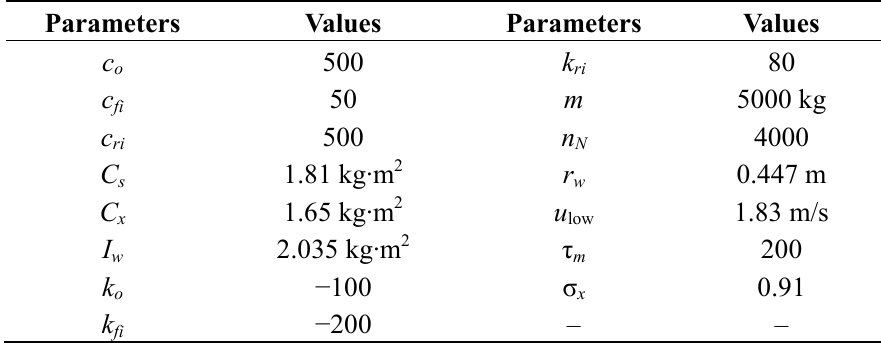
Table 2. Simulation